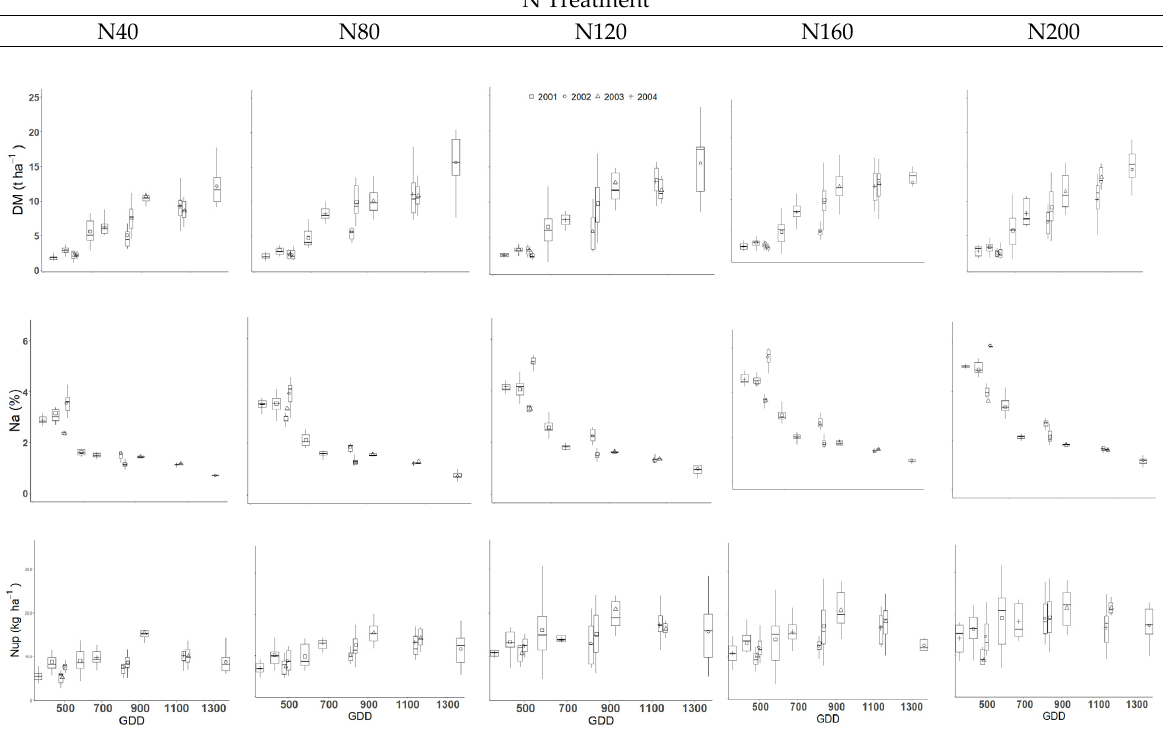
Figure 3. Boxplot showing the mean and the standard deviation for N up , N a and DM measurements for 2001, 2002, 2003, 2004 per GDD for each N treatment.